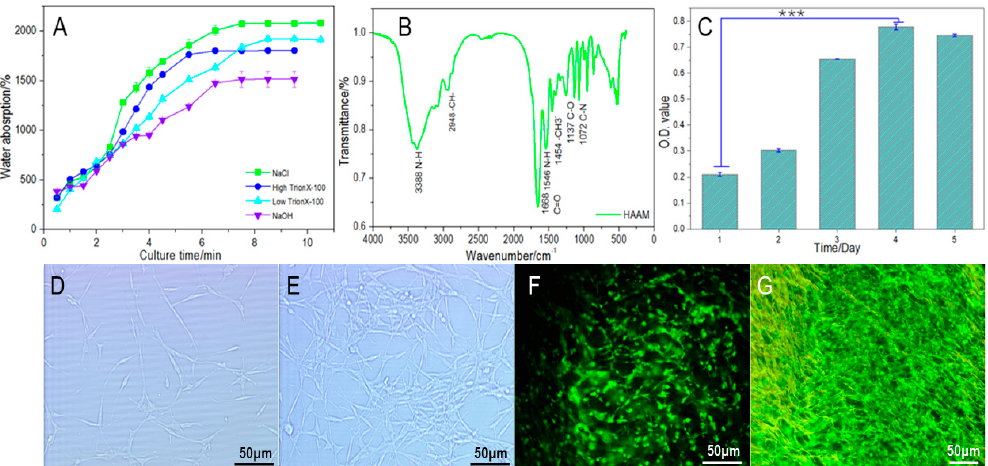
Figure 3. Physicochemical properties and biocompatibility of HAAM. ( A ) Water absorption curve of HAAM by different methods; ( B ) Infrared spectroscopy of HAAM; ( C ) Proliferation activity of PC12 on HAAM, ***: p < 0.001; ( D , E ) Microscopic observation of PC12 cells cultured 2 and 4 days; ( F , G ) The fluorescence staining of PC12 cells cultivated on freezing dried HAAM cultured 2 and 4 days.